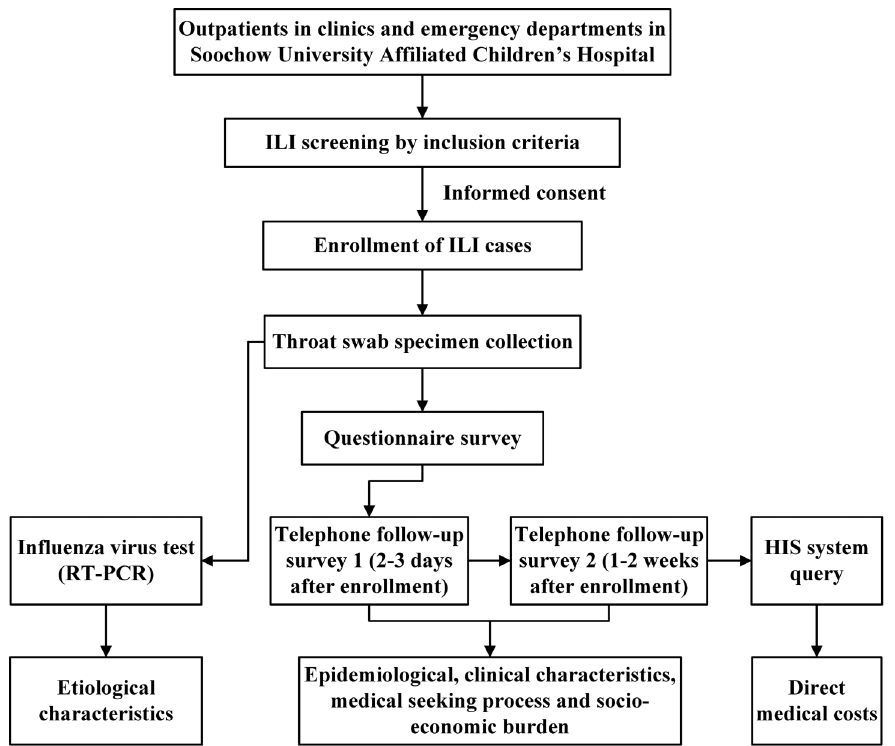
Figure 1. Study flowchart.